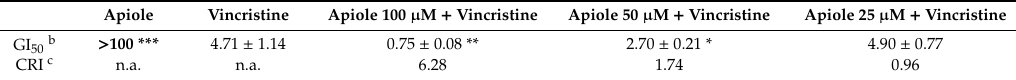
Table 4. Antiproliferative activity a expressed as GI 50 b ( µ M) of apiole, vincristine, and their association against the multidrug-resistant ovarian adenocarcinoma cell line NCI / ADR-RES after 48 h exposure. Apiole Vincristine Apiole 100 µ M +